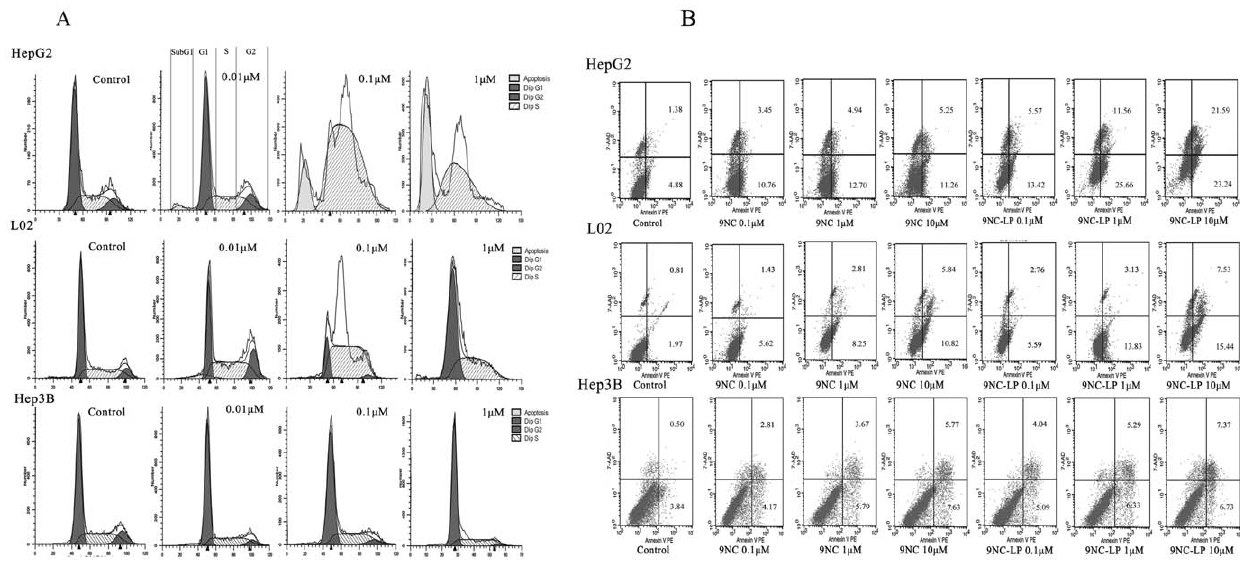
Figure 3. Cell cycle arrest and apoptosis-induced effects of 9NC and 9NC-LP on HepG2, L02 and Hep3B cells invitro . For the cell cycle analysis, cells were seeded at 2 6 10 5 to 3 6 10 5 per well in six-well paltes in triplicates and incubated with compounds. After treated for 24 h, 48 h and 72 h, cells were fixed, permeabilized, stained with PI and analyzed by flow cytometry. Results showed cells were incubated with 0, 0.01, 0.1, 1 m mol/L 9NC-LP for 24 h (A) . Apoptosis of HepG2, L02 and Hep3B cells (B) was measured by flow cytometry after stained with AnnexinV-PE and 7-AAD (Concentration: 0, 0.1, 1, 10 m mol/L). This experiment was done in triplicate and representative diagrams are shown (There no significant differences between cells treated with 4 % DMSO, Liposomes (free) and untreated cells. Data not shown).